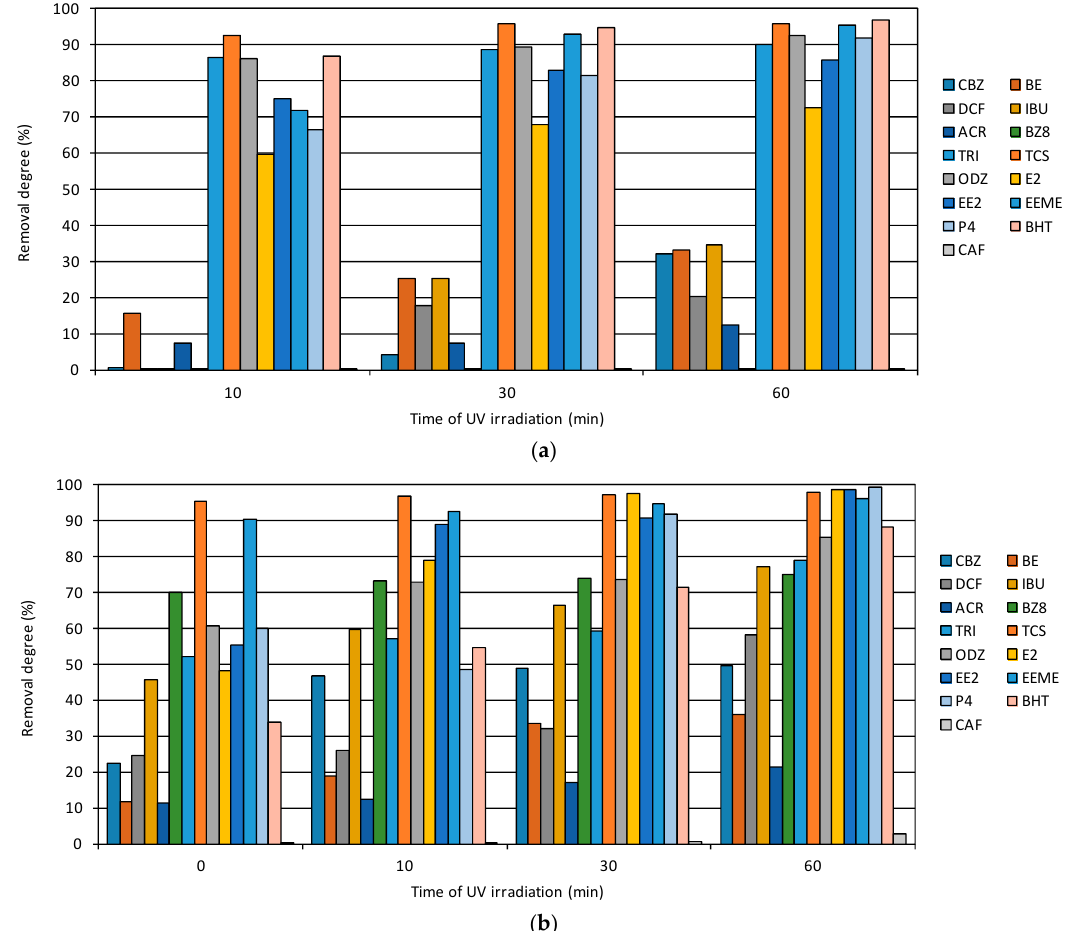
Figure 3. Degradation of micropollutants in the ( a ) UV and ( b ) UV/TiO 2